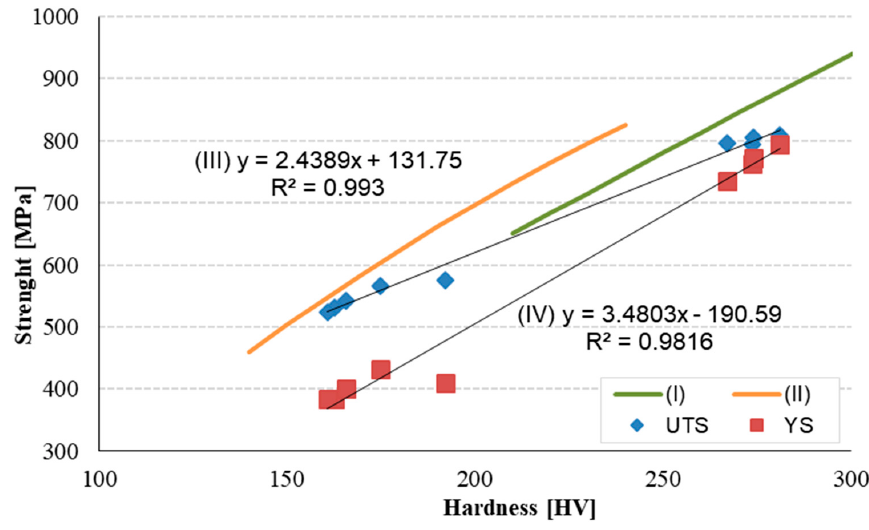
Figure 10. Mechanical properties as a function of hardness (HV).